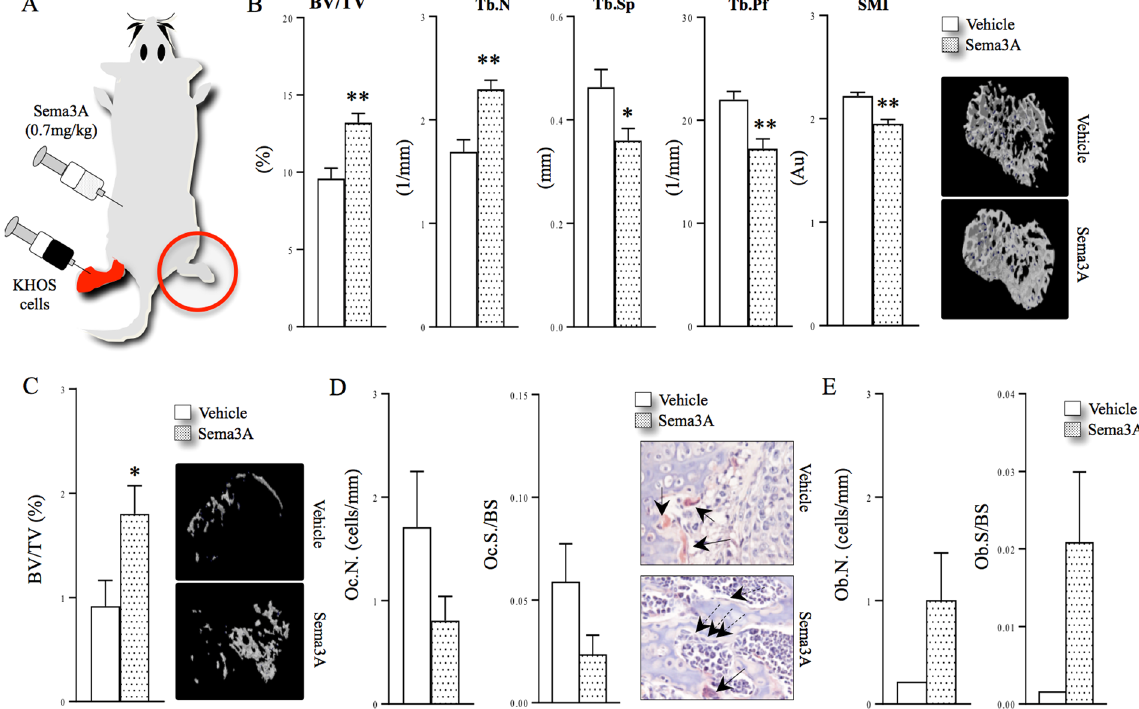
Figure 1. Exogenous Sema3A enhances bone volume in vivo . ( A ) Graphic representation of para-tibial injection of human KHOS cells treated with Sema3A (0.7 mg/kg) or vehicle (n = 7, 21 days) in 5 week old female Rj: NMRI nude mice. ( B ) Bone volume (BV/TV) and trabecular number (Tb.N), separation (Tb.Sp.), pattern factor (Tb.Pf) and structure model index (SMI) from non-inoculated tibia (solid circle) from the mice described in panel A. Representative photomicrographs of microCT scan of trabecular bone from the experiment described are shown in the right. ( C ) Bone volume (BV/TV) from tumour-bearing tibia from the mice described in panel A. Representative photomicrographs of microCT scan of trabecular bone from the experiment described are shown on the right. ( D ) In vivo osteoclast number (Oc.N, left) and osteoclast surface (Oc.S/BS, middle) from tibial metaphysis from mice from the experiment described in panel C. Representative photomicrographs of TRAcP positive osteoclasts indicated with solid arrows and osteoblasts indicated with dotted arrows from the experiment described are shown on the right. ( E ) In vivo osteoblast number (Ob.N, left) and active osteoid surface (Ob.S/BS, middle) from tibial metaphysis from mice from the experiment described in panel C-E. Data are mean ± SEM, n = 7 and n = 5 for histomorphometry * p < 0.05, ** p <